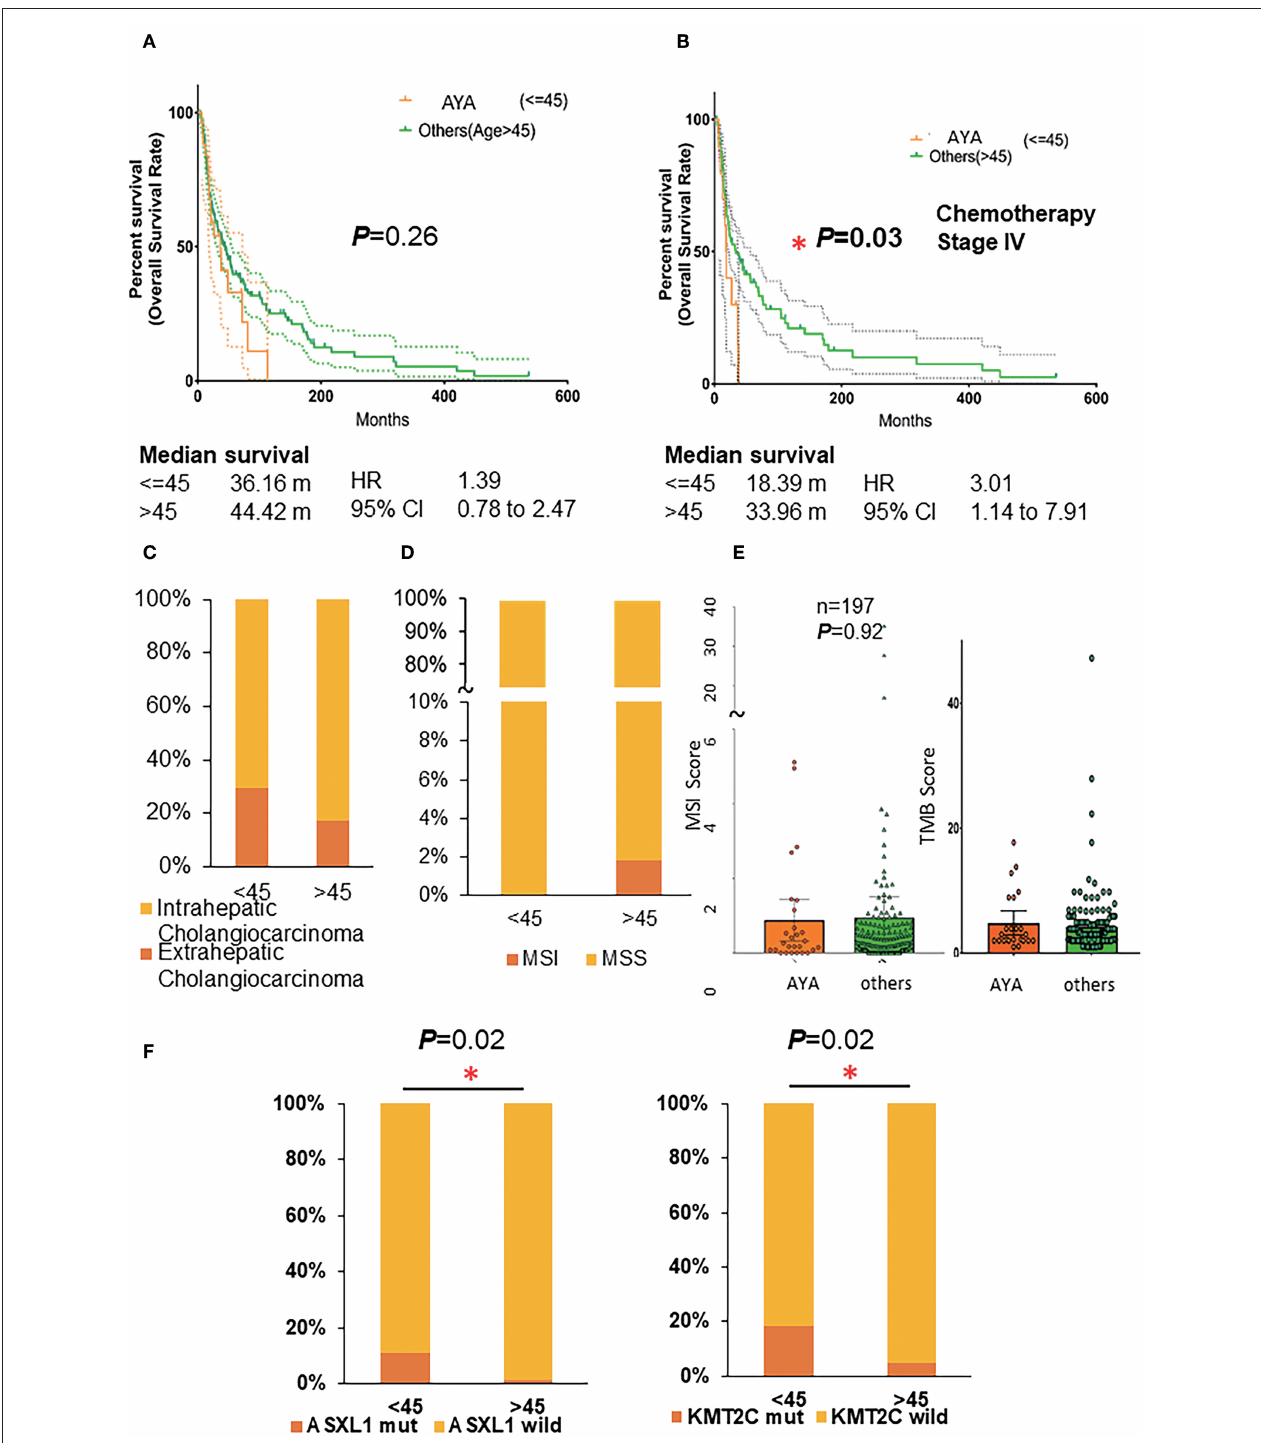
FIGURE 1 | (A) Overall survival rate of AYA patients and others (age > 45). (B) Overall survival rate of AYA patients and others (age > 45) with stage IV cholangiocarcinoma and underwent the treatment of chemotherapy. (C) The proportion of intrahepatic and extrahepatic cholangiocarcinoma in AYA ( < = 45) and other ( > 45) groups. (D) The MSI/MSS status of patients in AYA ( < = 45) and other( > 45) groups. (E) The MSI score and TMB score of patients in AYA ( < = 45) and other ( > 45) groups. (F) The mutation frequency of ASXL1 and KMT2C of patients in AYA ( < = 45) and other ( > 45) groups basing on cohort 3 (MSKCC). AYA, adolescents and young adults; MSI, microsatellite instability; TMB, tumor mutation burden.